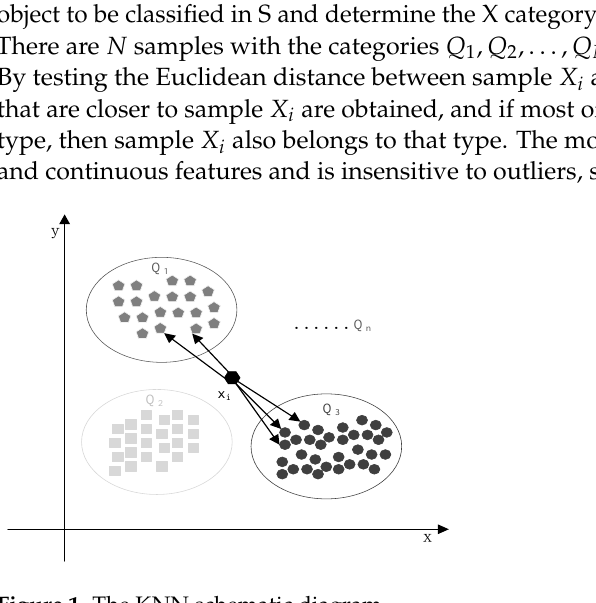
Figure 1. The KNN schematic diagram.